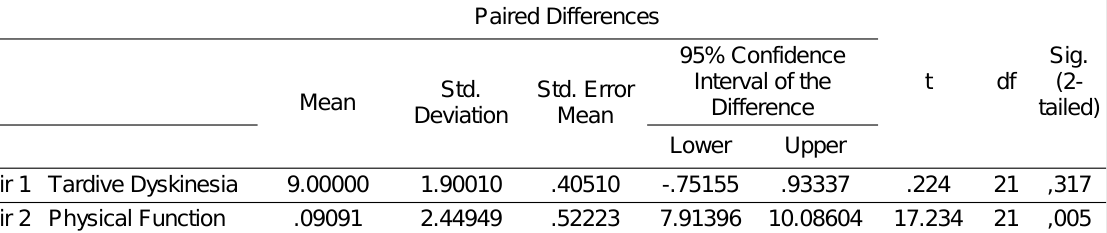
Table 5. Analysis of Variables on Sedation administration in Critical patients at Intensive